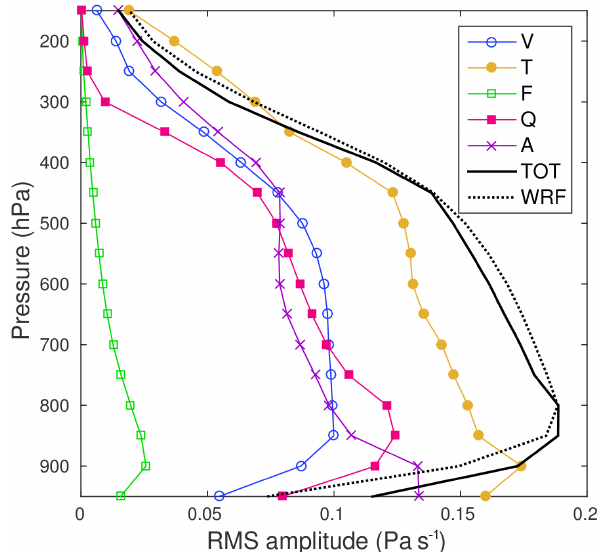
Figure 4. RMS amplitudes of ω WRF , ω TOT , and the individual ω components from Eq.